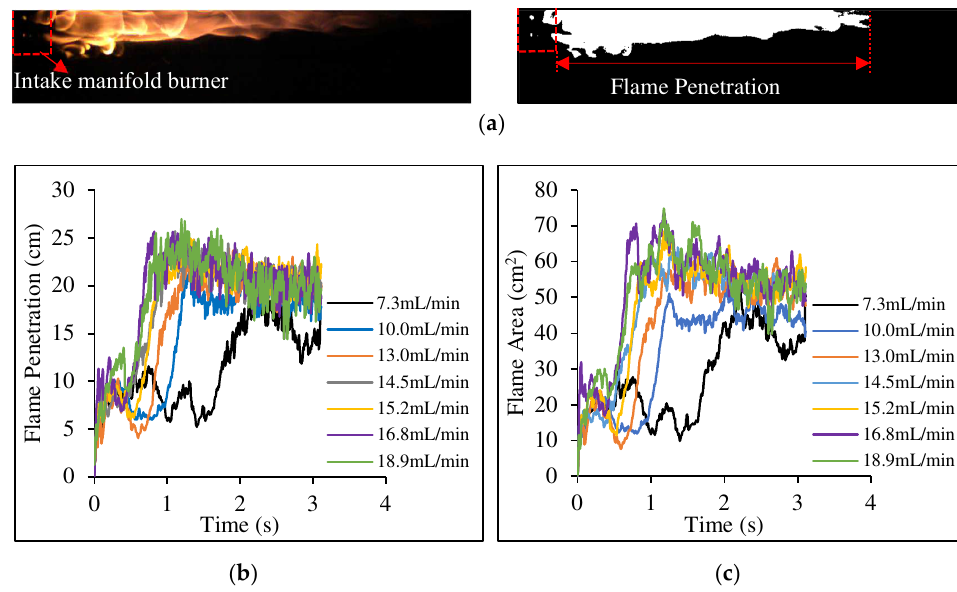
Figure 7. ( a ) Image processing; ( b ) flame penetration, and ( c ) flame area under different diesel flow rates with the air flow velocity of 1.4